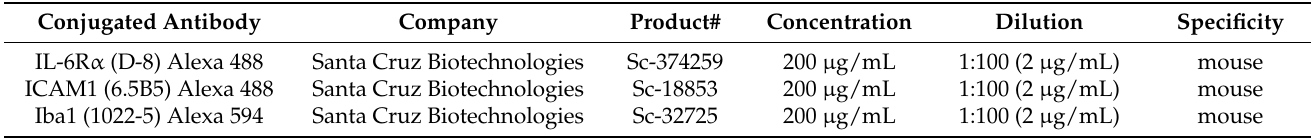
Table 2. Primary antibody information for conjugated